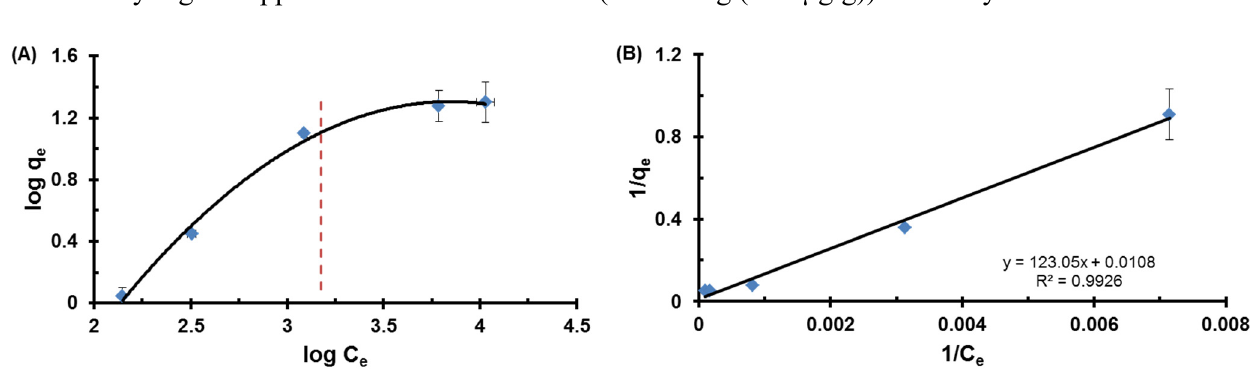
Figure 2. ( A ) Freundlich log-log plot of solid-phase concentration (q e ) versus liquid-phase concentration (C e ) at equilibrium. Dashed vertical line represent mean metaldehyde removed per treatment cycle as determined from Figure 3A; ( B ) Langmuir plot for the metaldehyde/Nyex TM 1102 system, where q e and C e are in µg/g and µg/L, respectively. Bars indicate the error, when they are not visible the error bar is smaller than the symbol